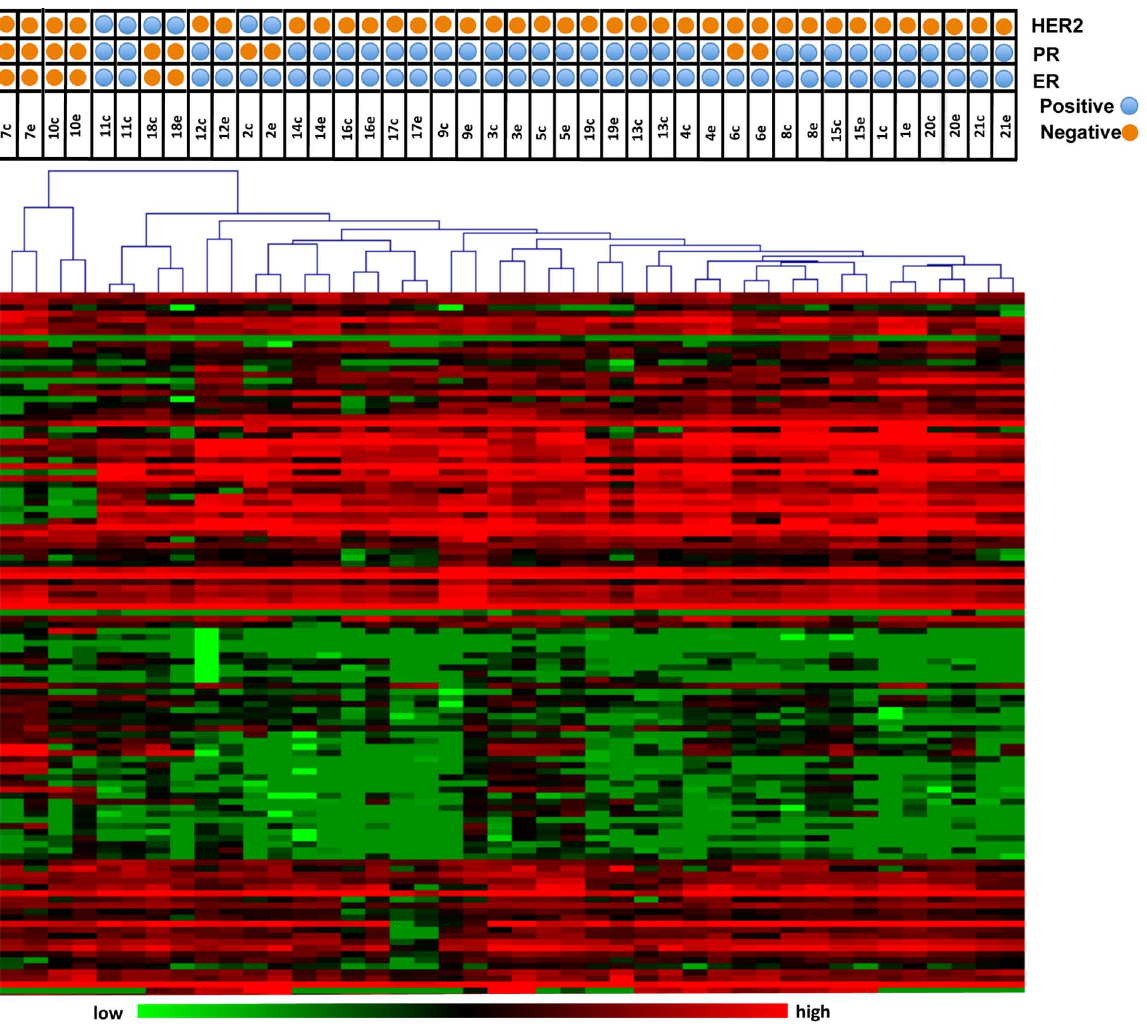
Figure 2. Heatmap of unsupervised clustering of both the CNB and EB samples. Heatmap of unsupervised clustering of all the samples and all the transcripts. All of the CNB and EB pairs co-aggregated at the first level dendrogram.